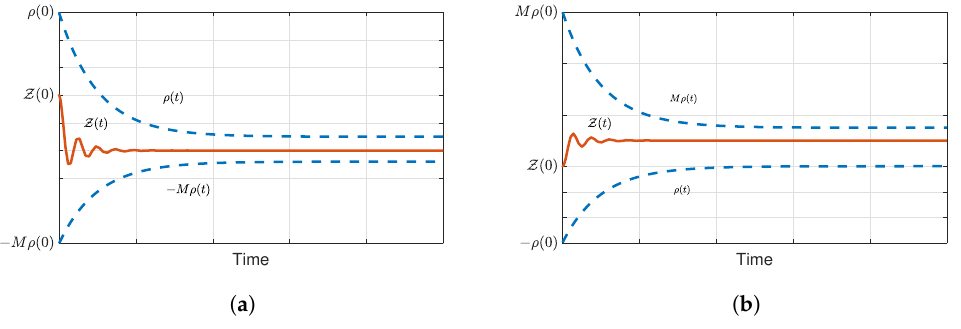
Figure 3. Curve of tracking error and performance function relationship: ( a ) Z (0) > 0 and ( b ) Z (0) <